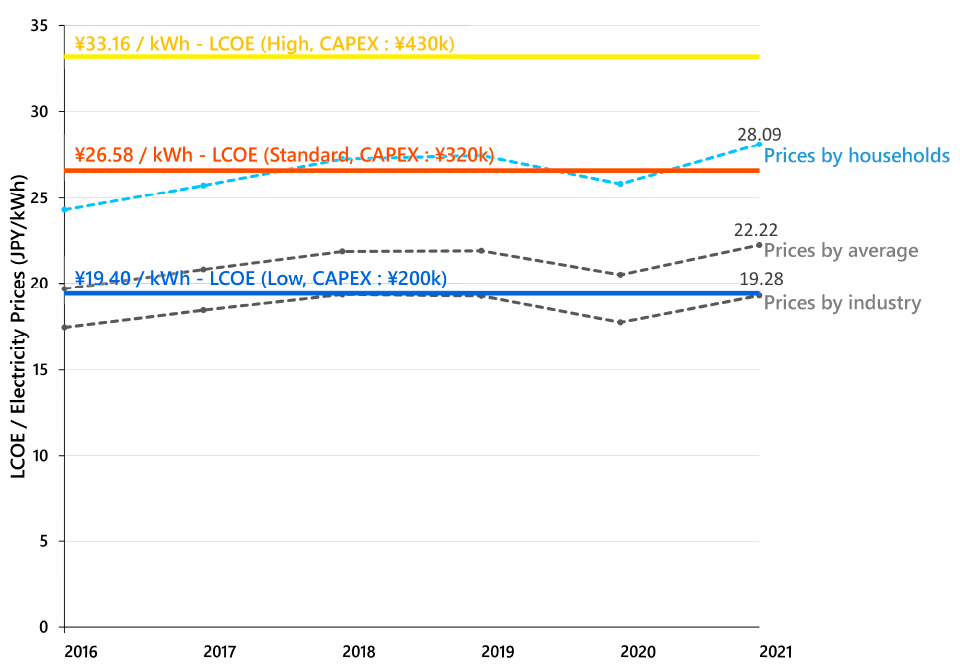
Figure 8. LCOE and electricity price trends.